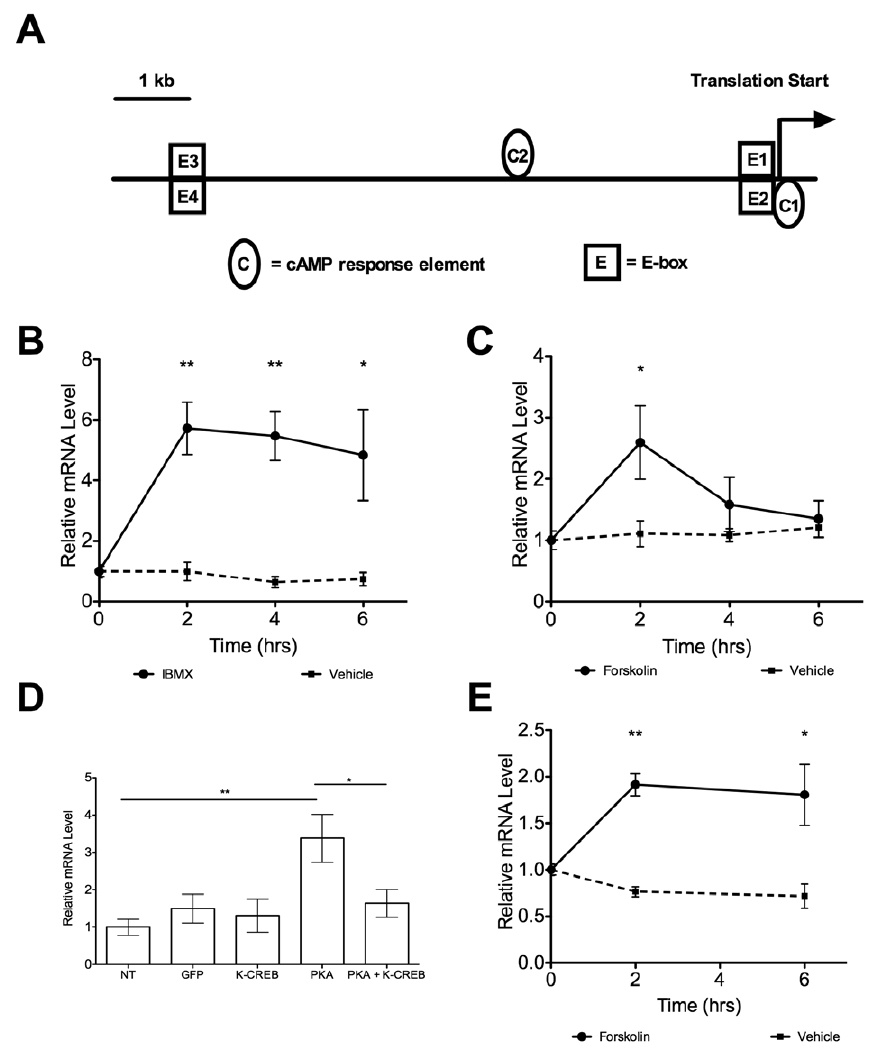
Figure 5. Nocturnin is induced by a rise in cAMP in NIH-3T3 fibroblasts and in 3T3-L1 adipocytes. ( A ) Schematic representation of highly conserved putative transcription factor binding sites in the 10 kb region upstream of Nocturnin’s translation start site. C= cAMP response element binding protein (CRE) sites. E= E-box elements. Locations of the CRE sites are C1 2 29 bp and C2 + 3,016 bp. ( B ) Nocturnin is induced approximately 4.5 fold by IBMX (solid line) in NIH3T3 fibroblasts. No induction of Nocturnin was observed in the vehicle treated cells (dashed line). Data represent mean ( 6 SEM), normalized to Cyclophilin B . n=4 for each time point. P-value determined by t-test assuming equal variances, two-way p-value reported. ** p-value , 0.002; * p-value , 0.03. (C) Nocturnin is induced approximately 2.5 fold by forskolin (solid line) in NIH3T3 fibroblasts. The dashed line represents data from vehicle treated cells. Data represent mean ( 6 SEM), normalized to Cyclophilin B . n=3 for each time point. P-value determined by t-test assuming equal variances, two-way p-value reported. * p-value , 0.03. (D) Transient transfection assay of NIH3T3 fibroblasts showing Nocturnin is induced by the overexpression of PKA in a CREB-dependent manner. Data represent the mean ( 6 SEM), n=6 for each group. T- test assuming equal variances performed, p-value reported. ** = p-value , 0.01; * = p-value , 0.04. NT= non-transfected; GFP= GFP transfected; K- CREB= pCMV-KCREB (dominant negative) alone transfected; PKA= pCMV-PKA transfected; PKA + K-CREB = pCMV-PKA and dominant negative pCMV-KCREB were cotransfected. (E) Nocturnin is induced approximately 2 fold by forskolin (solid line) in mature 3T3-L1 adipocytes. The dashed line represents data from vehicle treated cells. Data represent the mean ( 6 SEM), n=3. ** = p-value 0.0009, and * = p-value 0.036. Data were normalized to Cyclophilin B